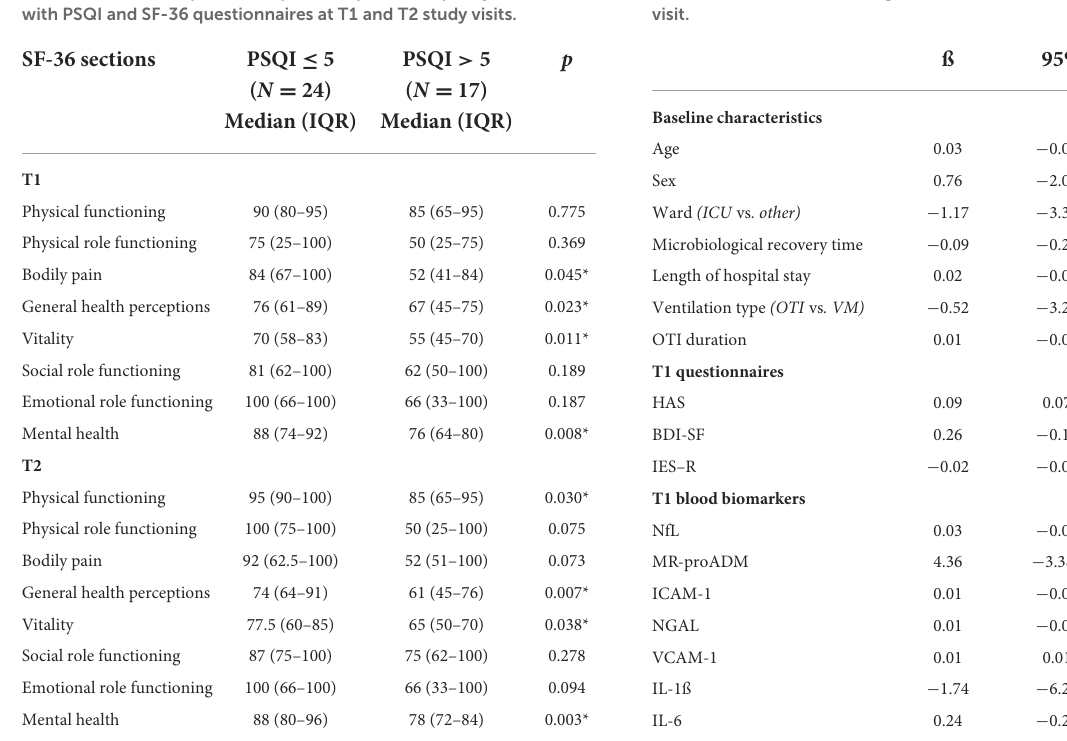
TABLE 3 Relationship between poor sleep and life quality assessed with PSQI and SF-36 questionnaires at T1 and T2 study visits.